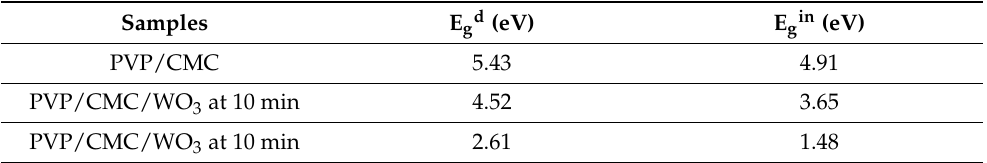
Table 1. The band gap [E gin and E gd ] values for polymer blends PVP/CMC and blends doped with WO 3 at 10 and 20